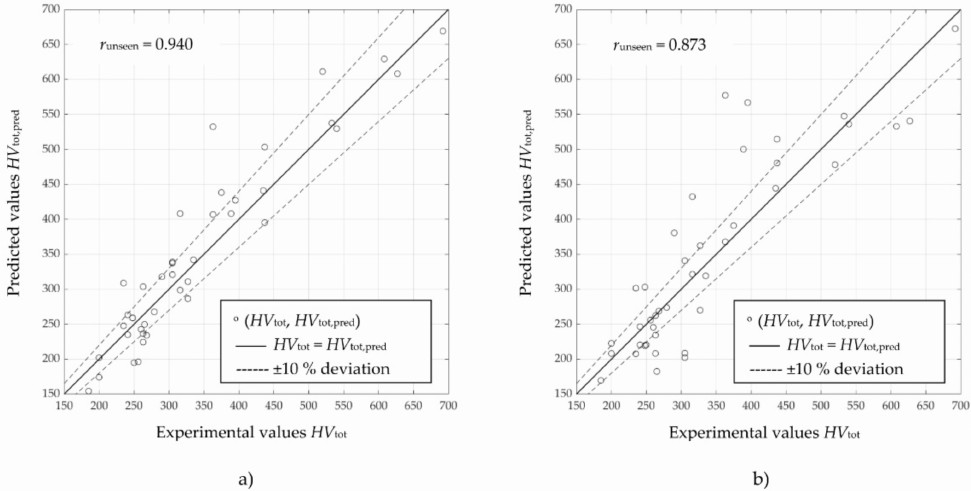
Figure 4. Scatter diagram of total hardness after continuous cooling HV tot values obtained by selected artificial neural networks of ( a ) configuration No. 1 and ( b ) configuration No. 2, on “unseen”